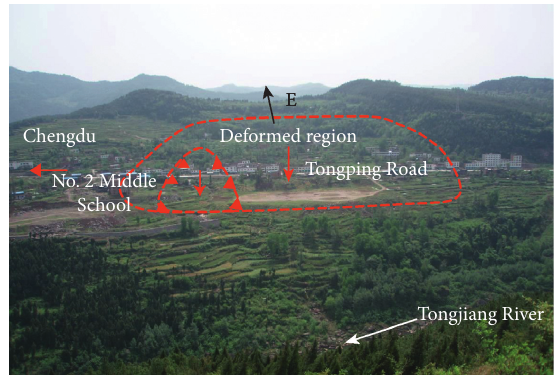
Figure 3: Plane view of Zhangjiawan